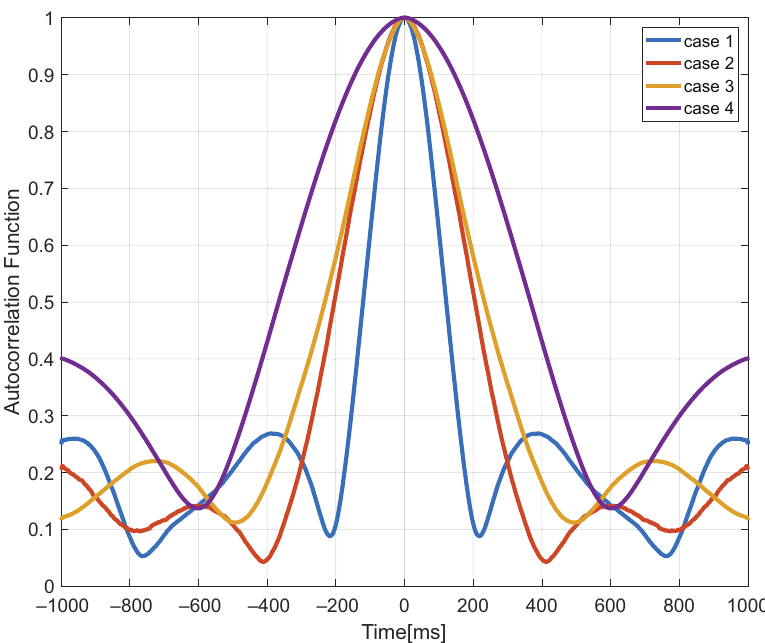
Figure 15. ICF correlation time curve in 4